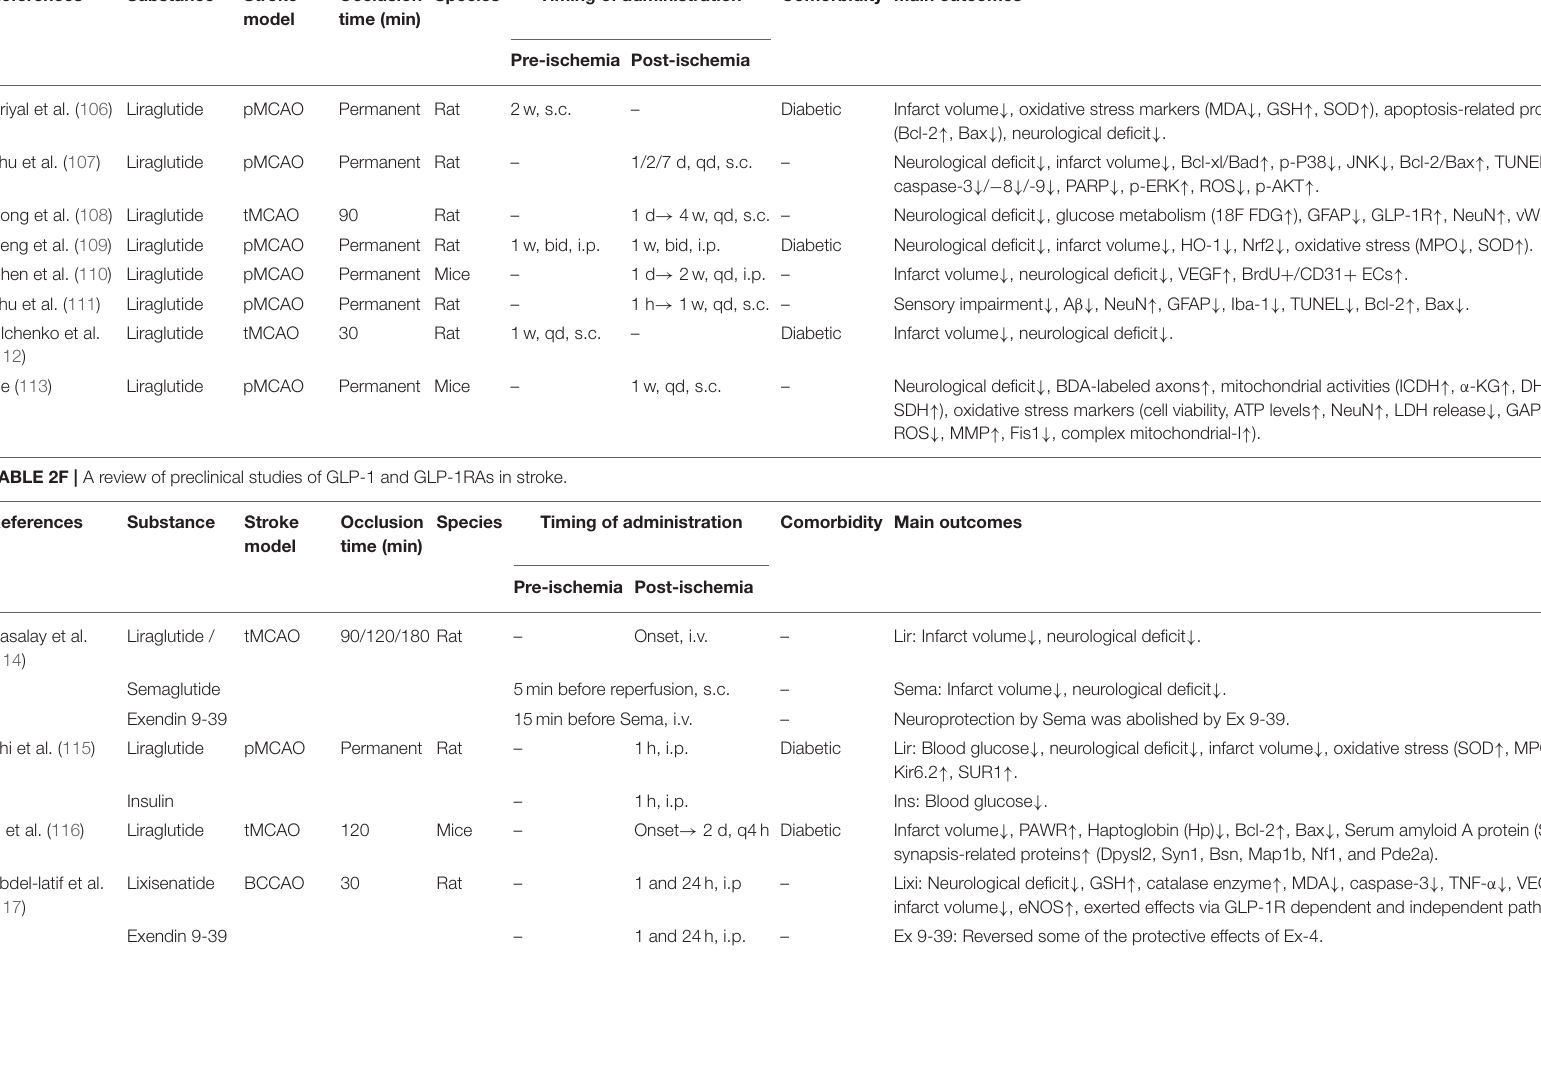
TABLE 2E | A review of preclinical studies of GLP-1 and GLP-1RAs in stroke.